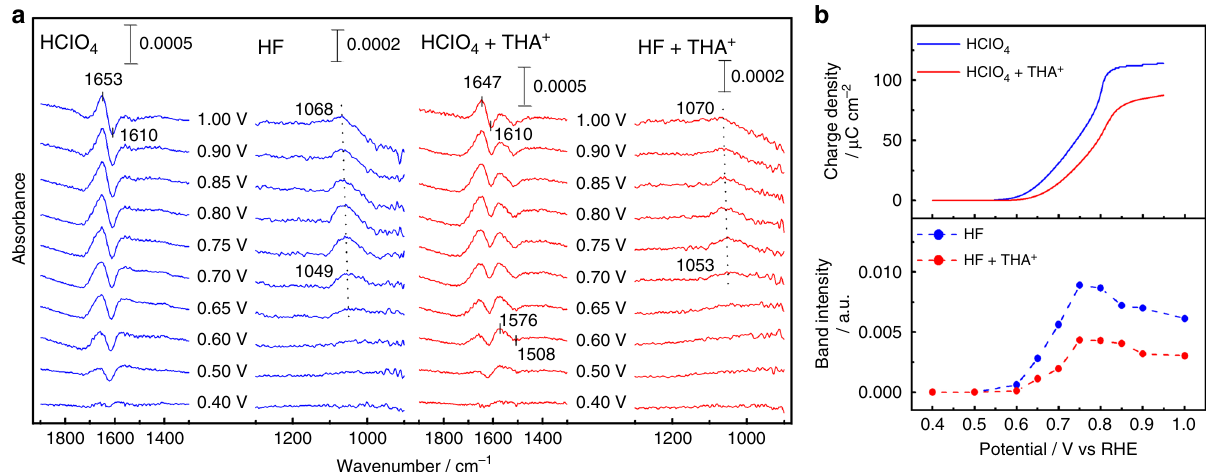
Fig. 2 Infrared spectroscopic measurement of species adsorbed on platinum(111). a Potential dependence of infrared spectra on Pt(111) and Pt(111) modi fi ed with tetra- n -hexylammonium cation (THA + ) in 0.1 M acidic solutions saturated with Ar. The potential of the background spectra is 0.30 V versus reversible hydrogen electrode (RHE). The potentials of the sample spectra are stepped in the positive direction. b Potential dependence of the charge density of Pt oxidation and the band intensity of δ